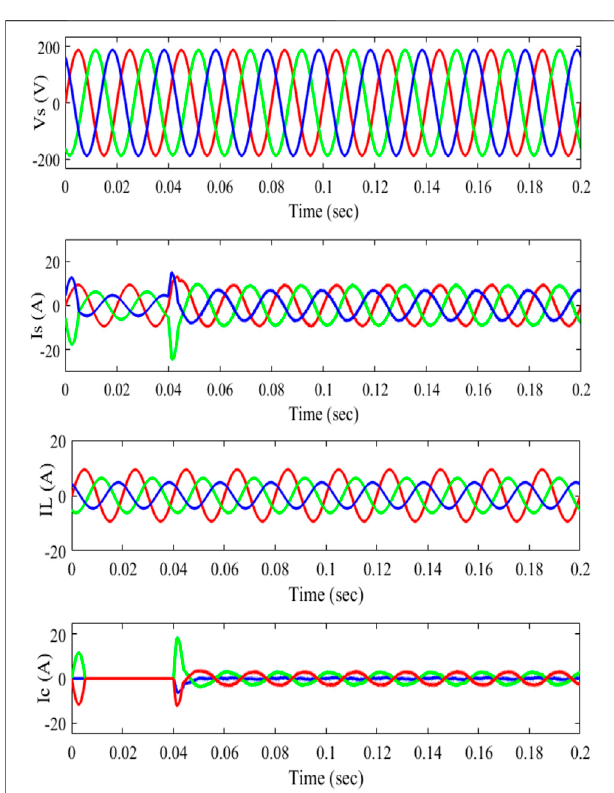
FIGURE 18 | Total harmonic distortion with GWO-based SHAPF.